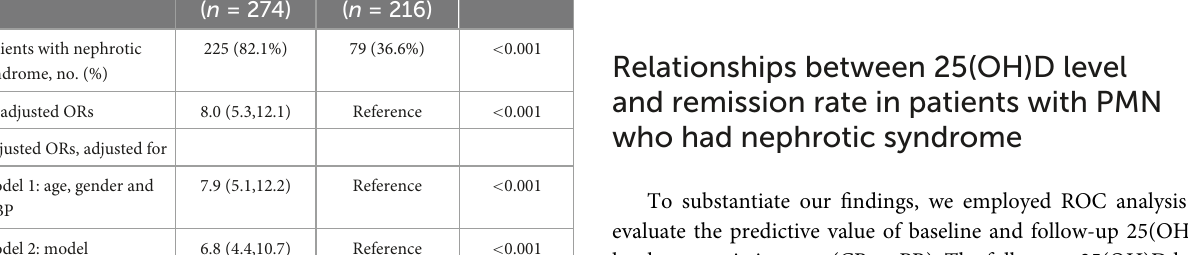
TABLE 2 Predicted performance of baseline 25(OH)D for patients with PMN who had the nephrotic syndrome. Variables Baseline 25(OH)D (nmol/L) P -value ≤ 19.55